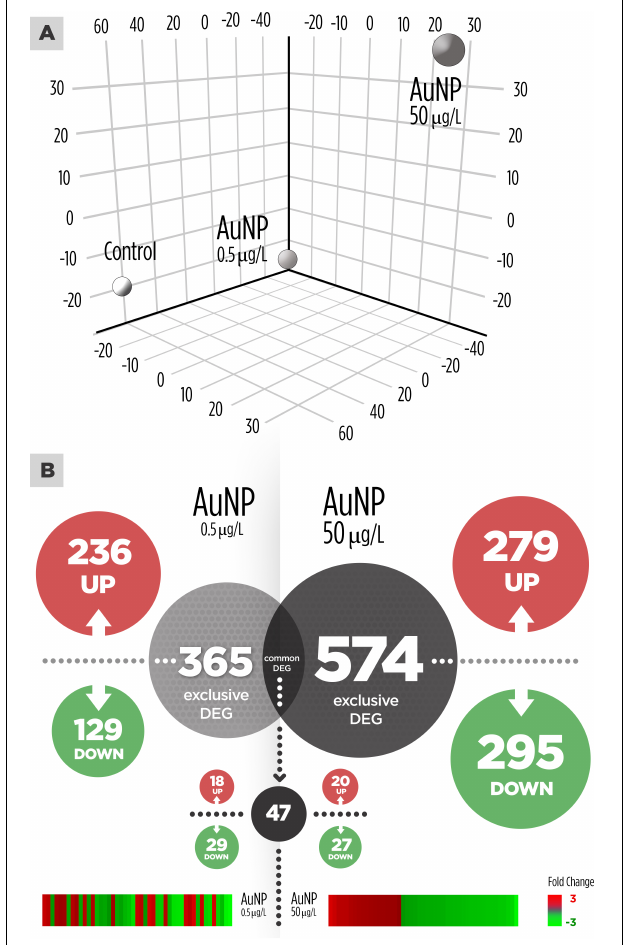
FIGURE 1 | Transcriptional overview in the liver of Sparus aurata after 24 h exposure to gold nanoparticles (AuNP). (A) Principal Component Analysis (PCA) 3D plot of the liver samples grouped by treatment. (B) Venn diagram representing differentially expressed genes (DEG). Light gray circle: 365 DEG after exposure to 0.5 µ g/L AuNP. Dark gray circle: 574 DEG after exposure to 50 µ g/L AuNP.